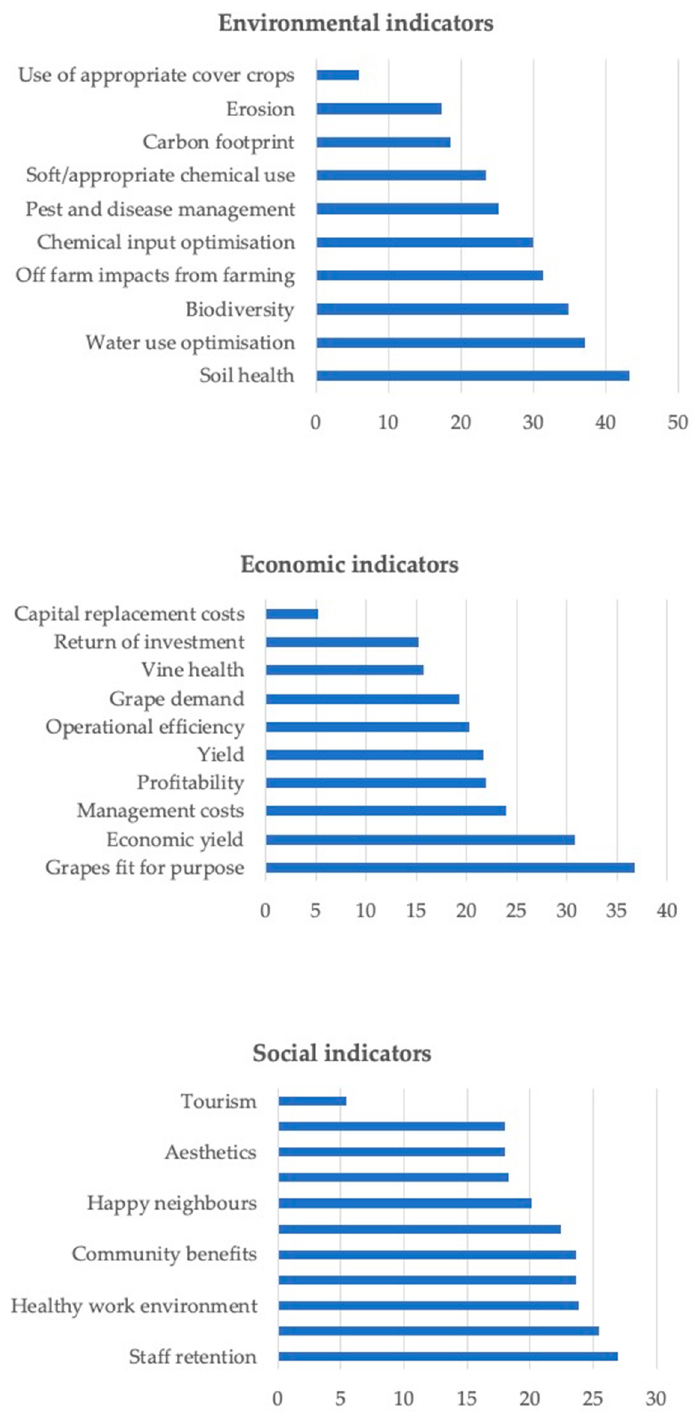
Figure 2. The main environmental, economic, and social sustainability indicators ranked according to their Importance Index (adapted from Santiago-Brown et al.